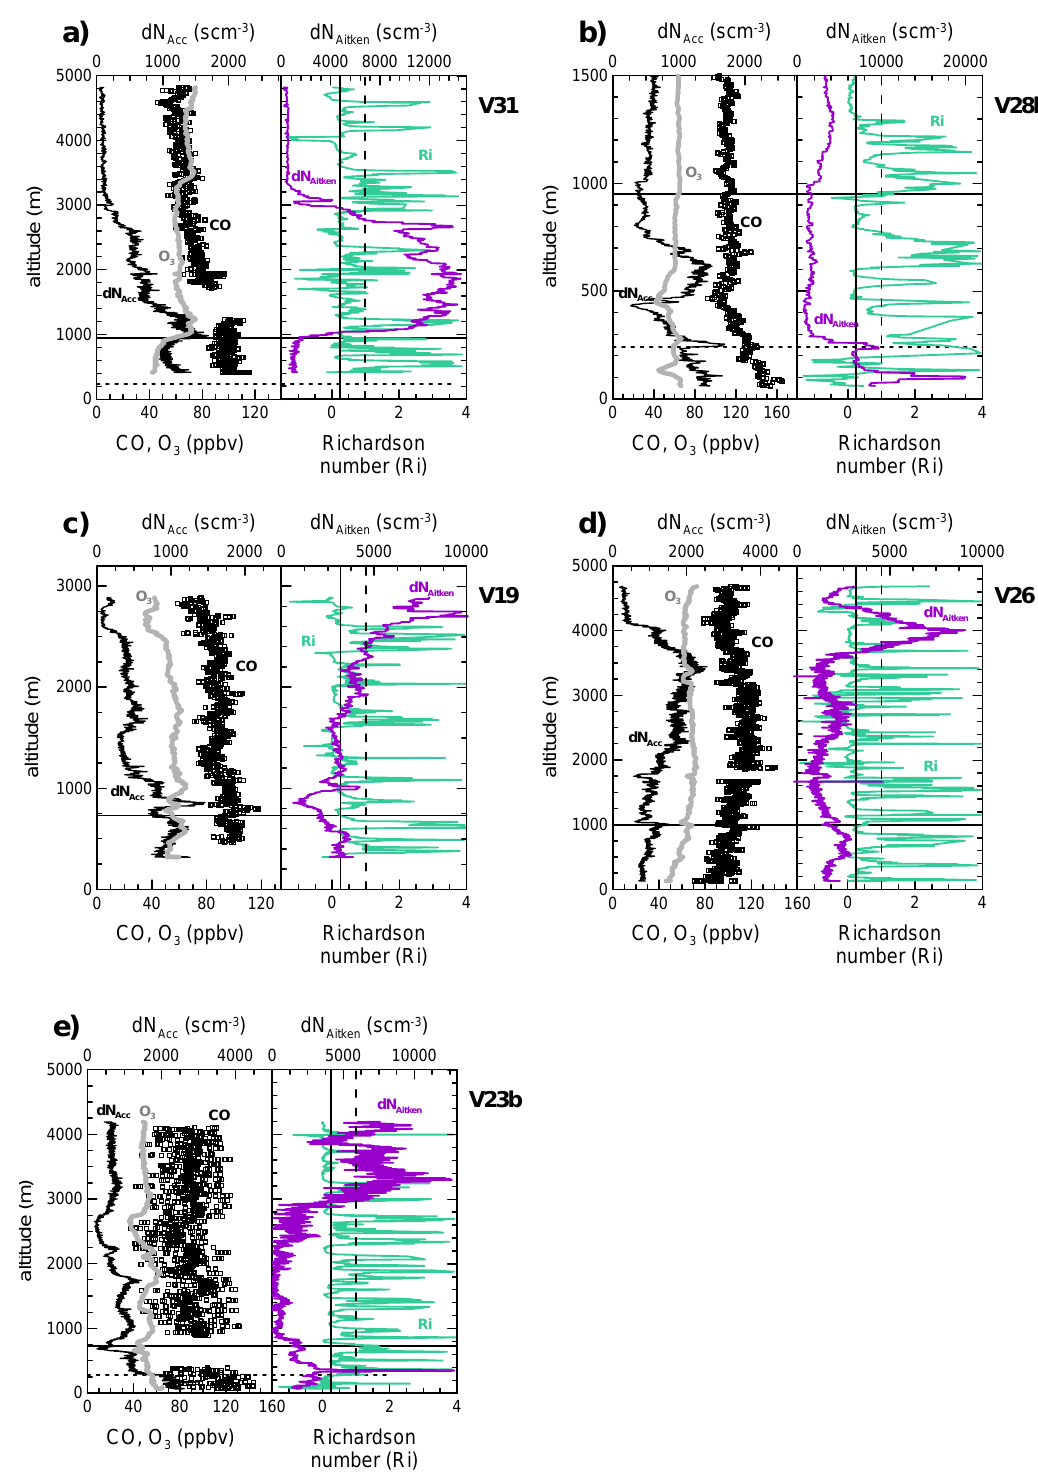
Figure 10. Vertical profiles of the accumulation and Aitken particle concentrations (d N Acc , black line, and d N Aitken , purple line), CO (black dots), O 3 (grey dots), and gradient Richardson number ( Ri , green line) for flights (a) V31, (b) V28, (c) V19, (d) V26 and (e) V23b. The horizontal lines indicate the height of the marine boundary layer MABL (dotted line) and the planetary boundary layer BL (continuous line), while the vertical lines indicate Ri crit = 0.25 and Ri = 1 (continuous and dashed lines,